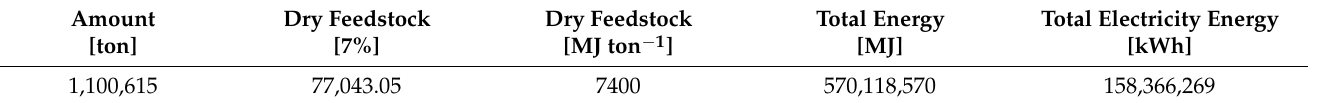
Table 7. The energy equivalent of total